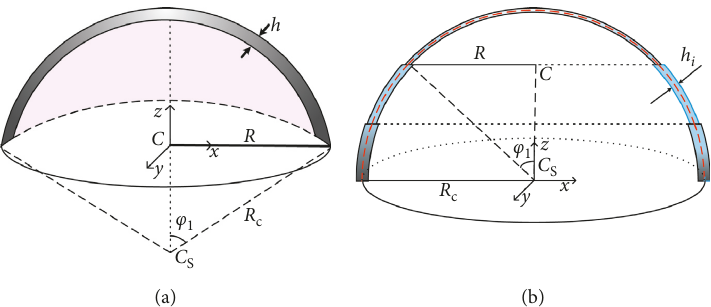
Figure 1: Symbols of geometric parameters and coordinates of spherical cap. (a) Uniform spherical cap. (b) Stepped spherical cap.